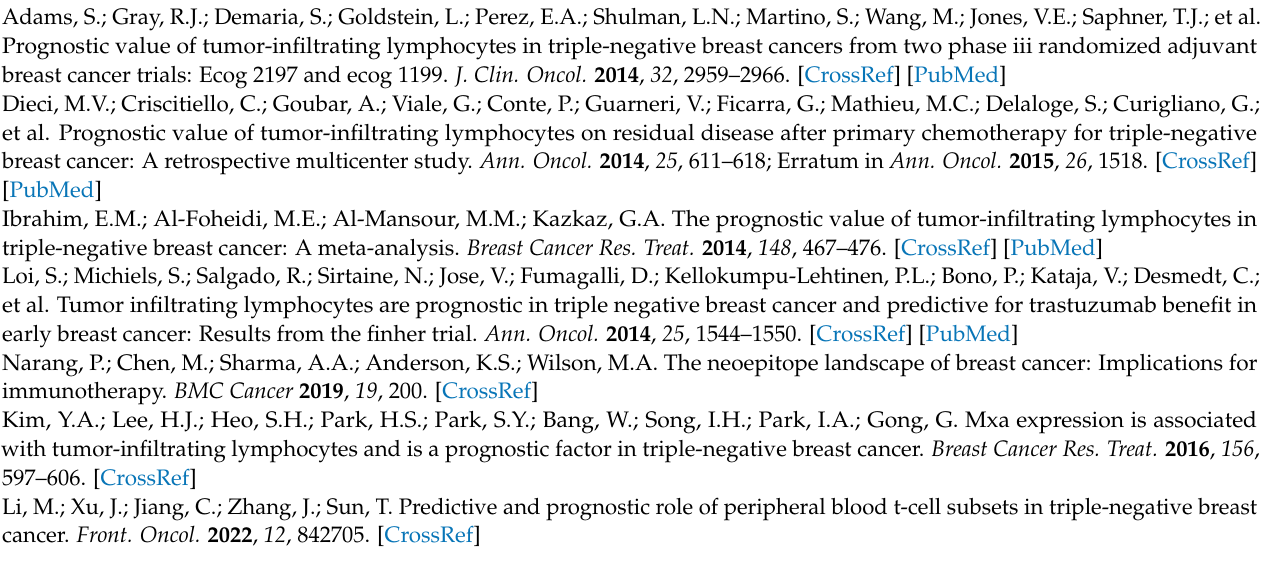
Figure S2: Kaplan-Meier survival analyses for cytoplasmic LXR in relation to the level of